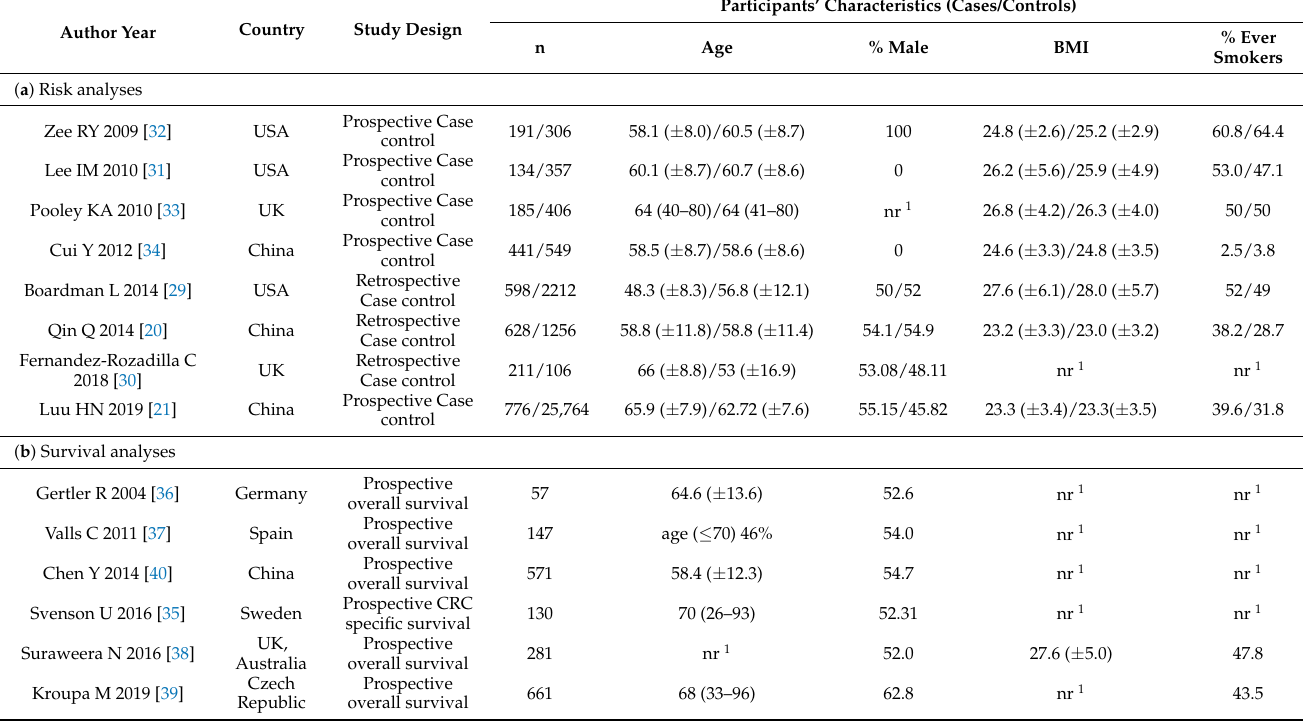
Table 1. General characteristics of studies (n = 14) included in the meta-analysis of the association between telomere length and (a) colorectal cancer risk, and (b) colorectal cancer